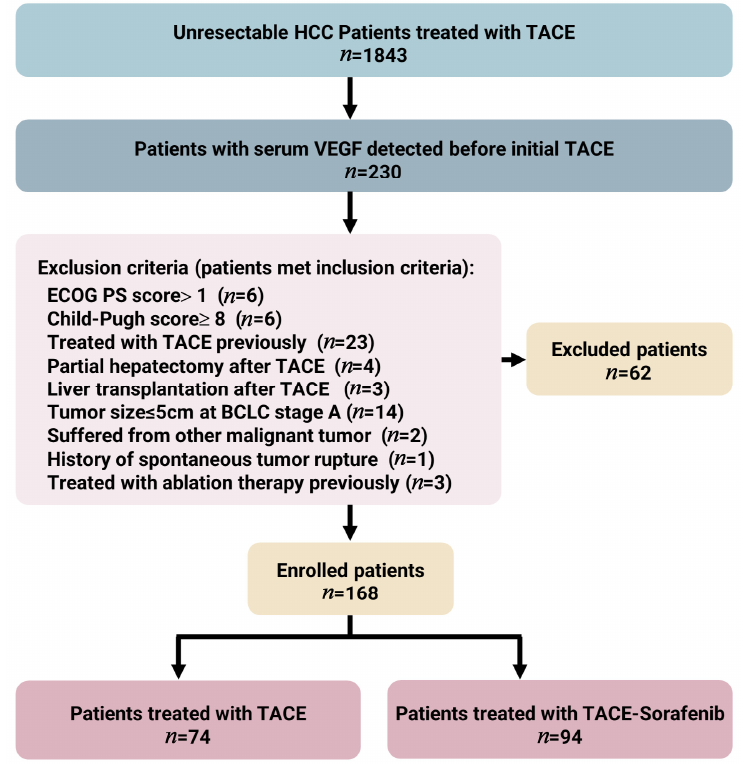
Figure 1. The flowchart of the study; “ n ” represents the number of patients.